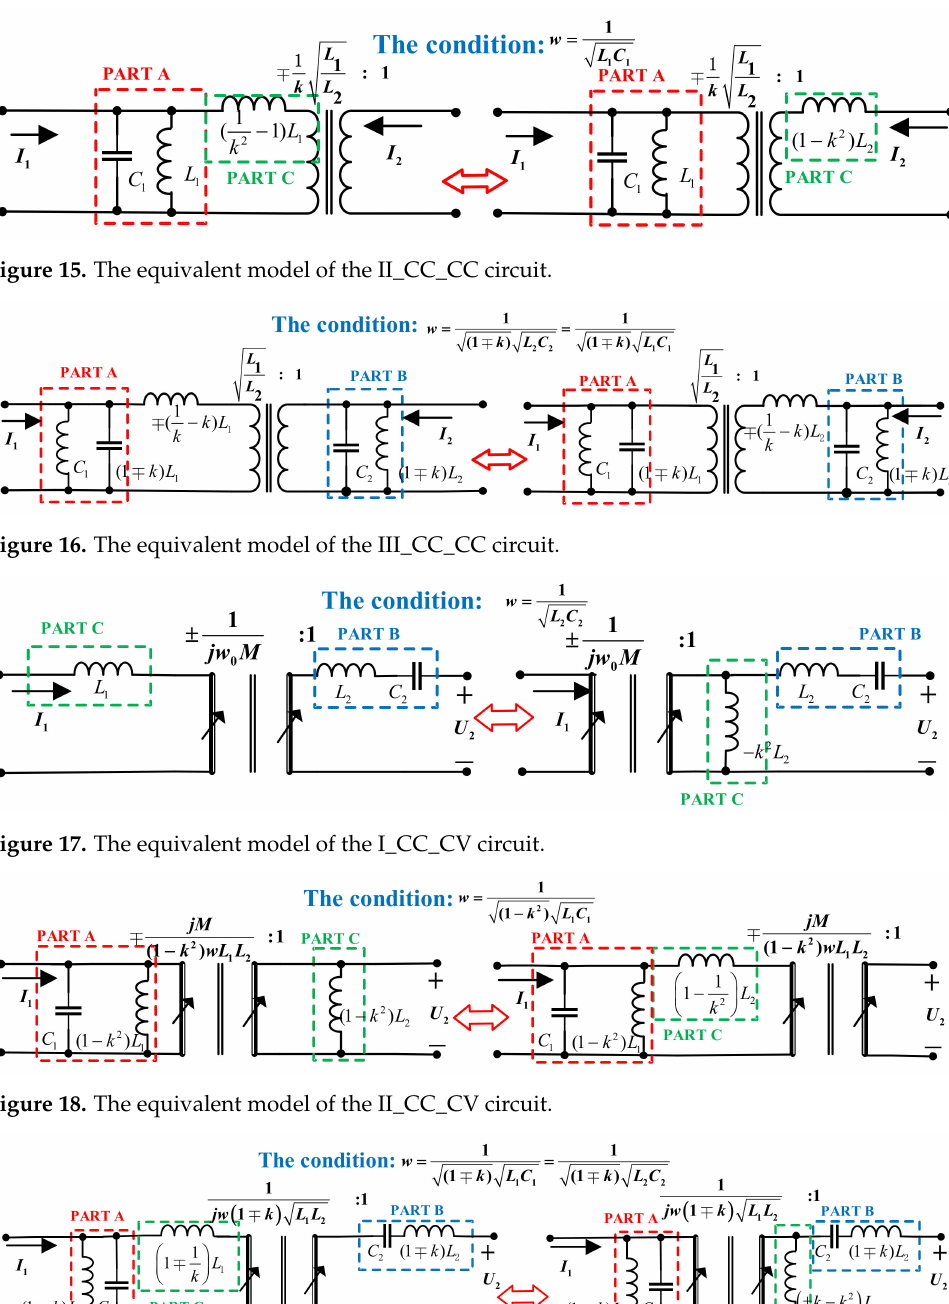
Figure 14. The equivalent model of the I_CC_CC circuit.